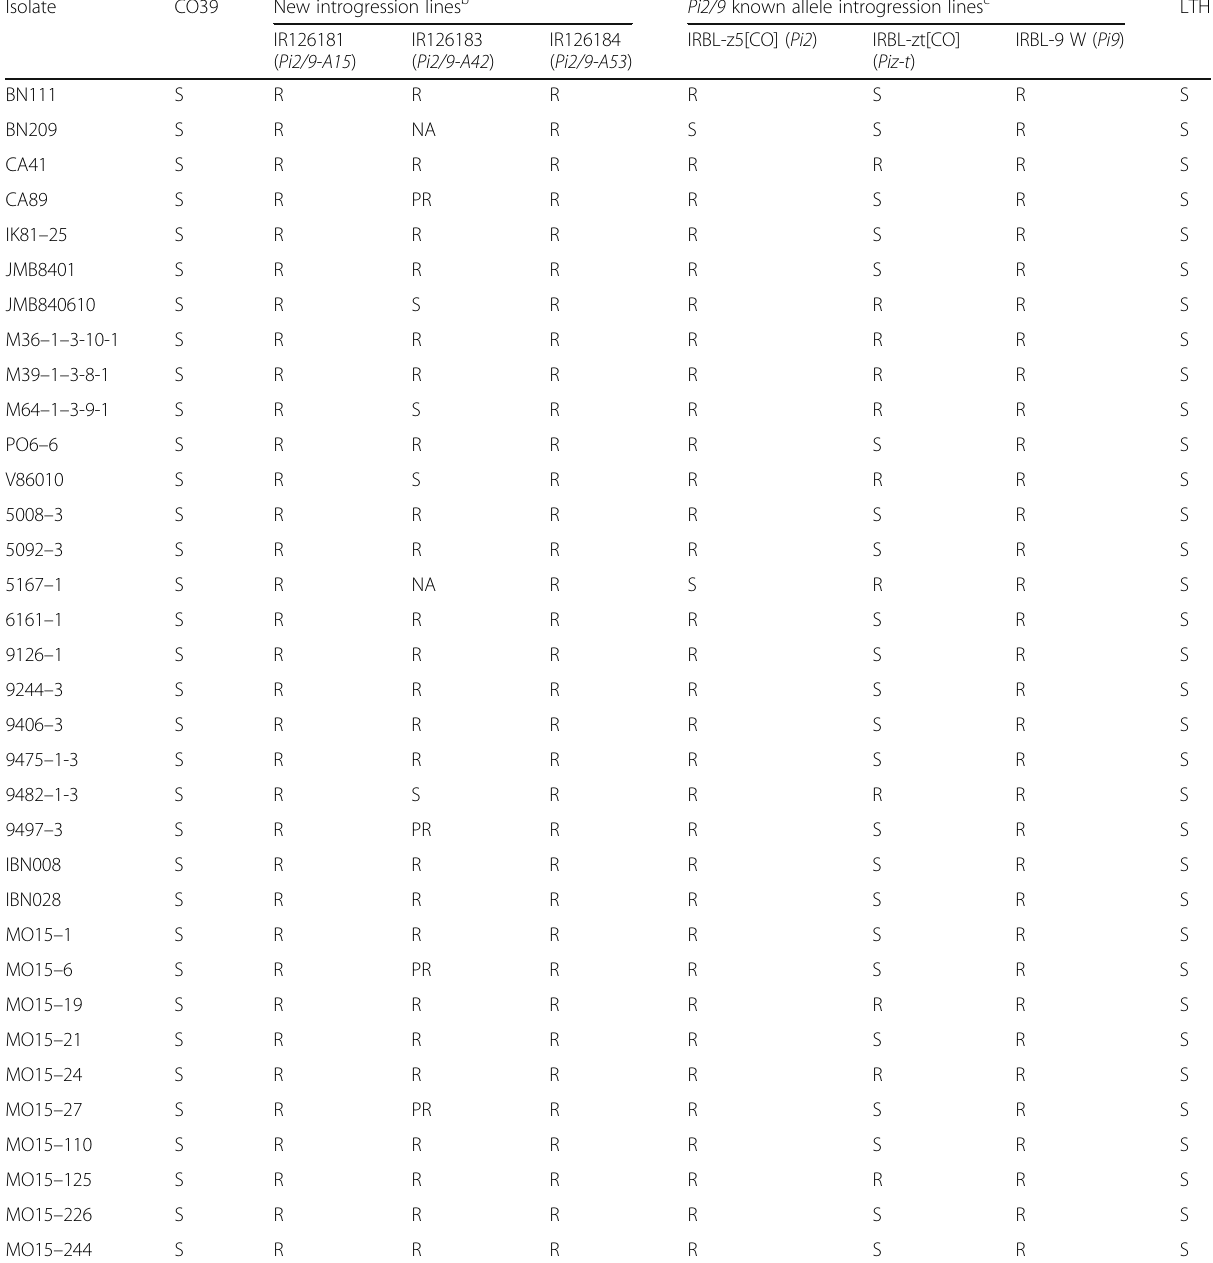
a R indicates resistance, PR indicates partial resistance, S indicates susceptibility and NA indicates not available. Resistance evaluations are based on the 0 – 5 scale of the Standard Evaluation System. b The three new introgression lines are all in the CO39 genetic background. c IRBL-z5[CO] and IRBL-zt[CO] are introgression lines of Pi2 and Piz-t in the genetic background of CO39; IRBL9-W is the introgression line of the Pi9 gene in the genetic background of